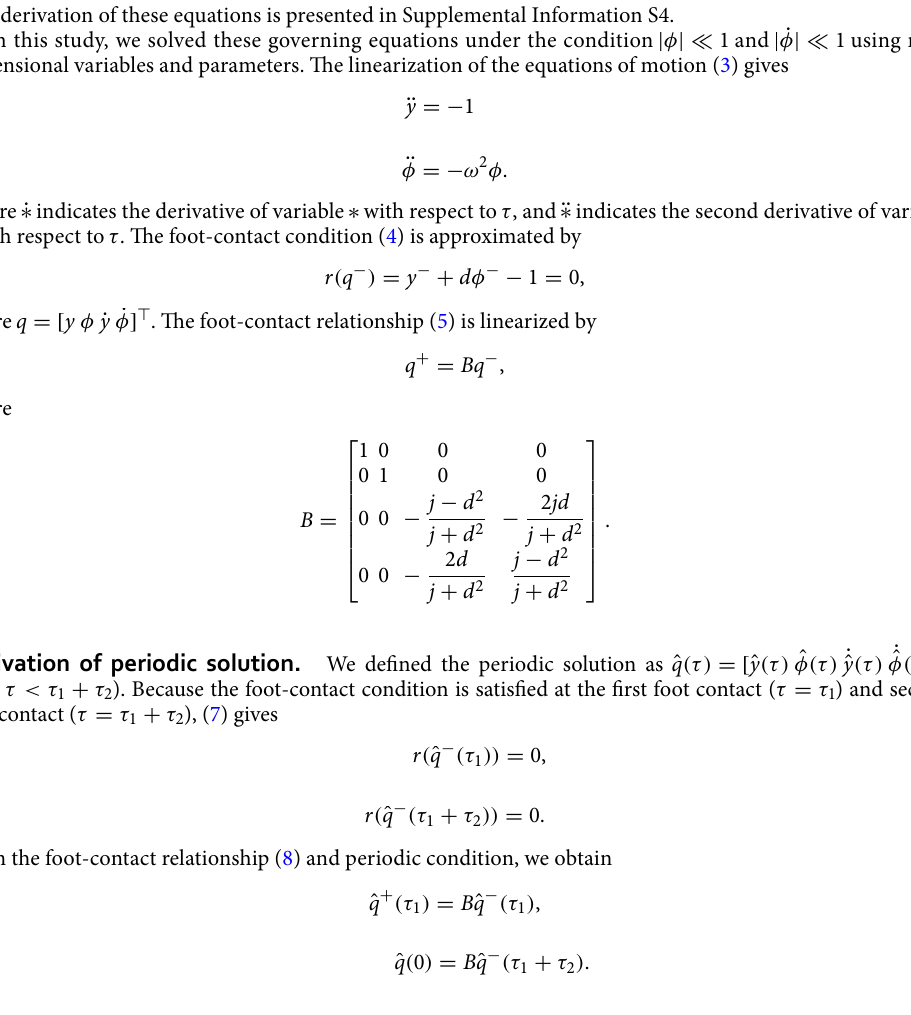
y + (τ 1 ) y ( 0 ) for y (τ) . ( b ) Symmetric periodic ˆ = ˆ ˆ τ 1 τ 2 / 2 = +